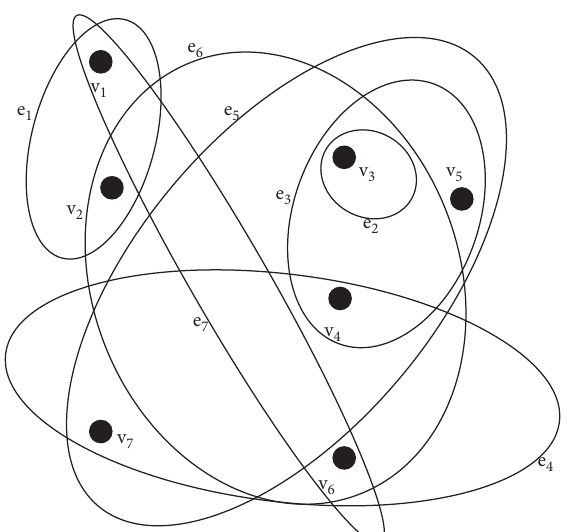
Figure 4: Graphical representation of